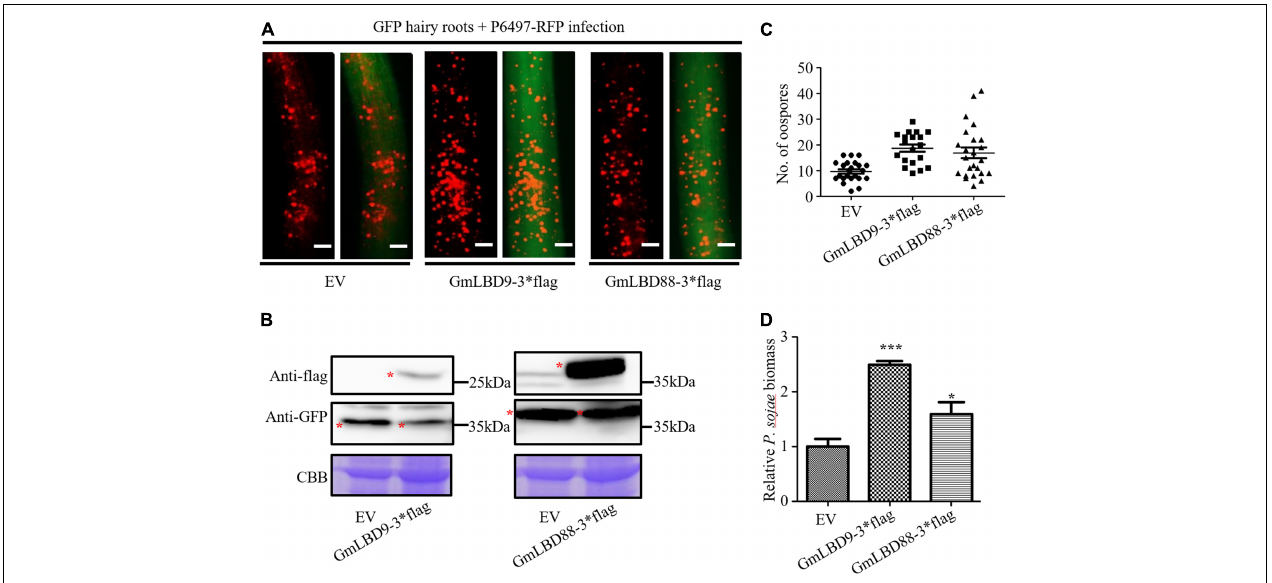
FIGURE 5 | Overexpression of GmLBD9 and GmLBD88 enhanced P. sojae infection. (A) Soybean hairy roots overexpressing EV, GmLBD9-3 ∗ flag, and GmLBD88-3 ∗ flag were selected based on the green fluorescence and then inoculated with P. sojae strain P6497-RFP. P. sojae oospores were observed at 48 hpi under a fluorescence microscope. Scale bars represent 0.28 mm. (B) Expression of recombinant proteins EV, GmLBD9-3*flag, and GmLBD88-3 ∗ flag was detected in western blot. Protein gel was stained with Coomassie blue as the loading control. (C) The number of oospores was counted. (D) Relative biomass of P. sojae was determined by qPCR at 48 hpi, and standard errors from three replicates are shown ( ∗ P < 0.05; ∗∗∗ P < 0.001; one-way